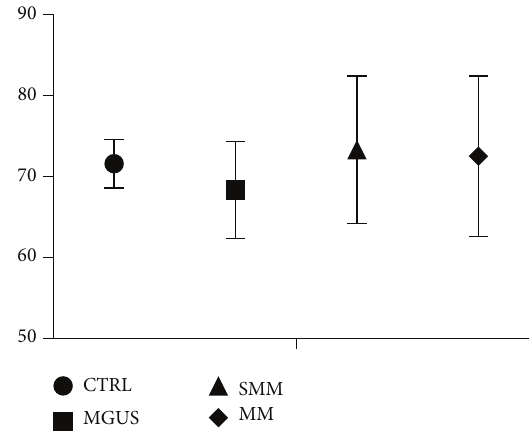
Figure 3: Percentage of inhibition of autologous CD4 + CD25 − cells in healthy controls (CTRL) (71.6% ± 3%), monoclonal gammopathy of uncertain significance (MGUS) (68.3% ± 6%), smoldering mul- tiple myeloma (SMM) (73.3% ± 9.1%), and active multiple myeloma (MM) (72.5% ± 9.9%) ( 𝑝